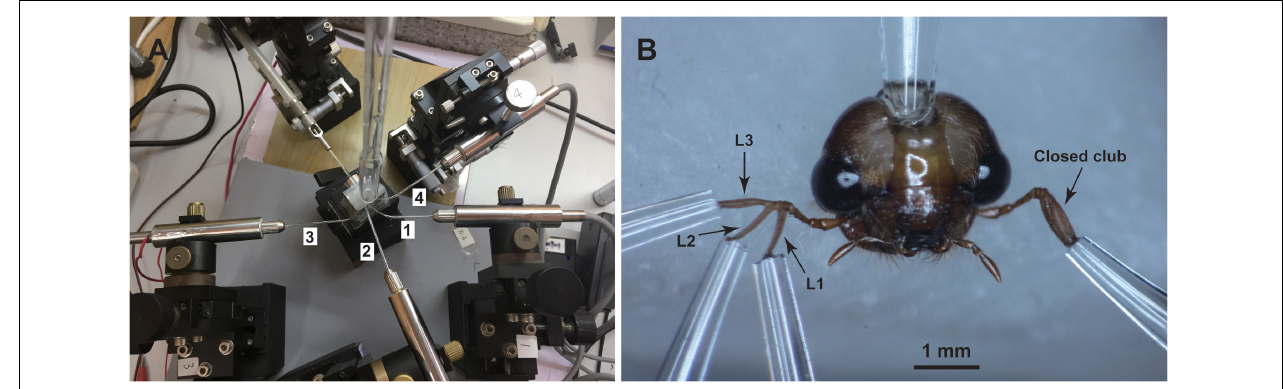
FIGURE 1 | Experimental set-up (A) and antennal preparation (B) for EAG recordings. The isolated head of a beetle was mounted on a dental wax stage. The reference electrode was connected to the neck while the recording electrodes were connected to the three separated lamellae, L1, L2, and L3, of one antennal club and the other closed club. The numbers 1, 2, 3, and 4 of the recording electrodes correspond to the lamellae L1, L2, L3, and one antennal club,